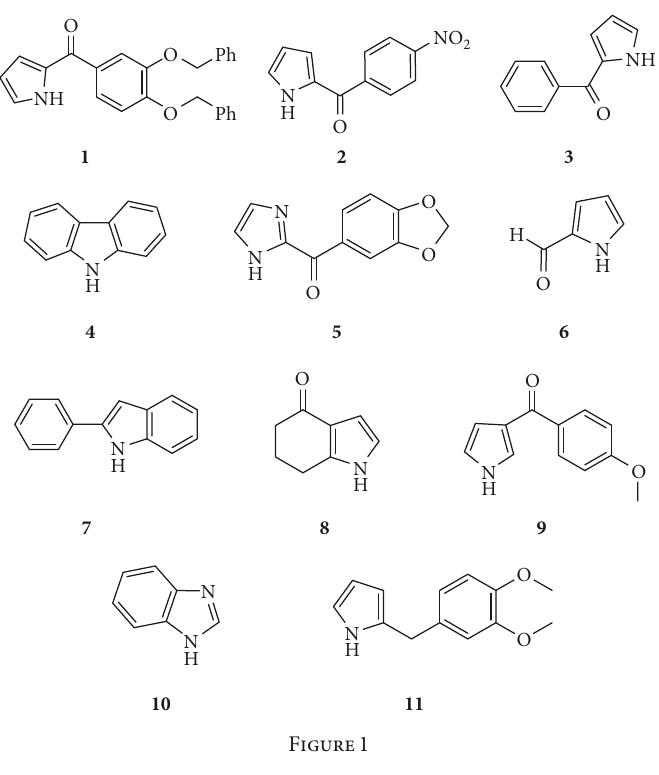
Table 1: Chemoselective alkylation of nitrogen heterocyclic rings with TEBAC. Starting material